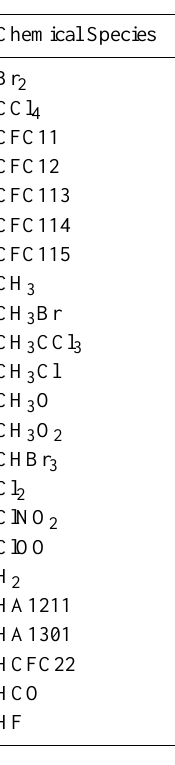
Table 1. Initial conditions for chemical species where mixing ratio is specified constant with altitude. Units are in mixing ratio. Initial mixing ratios that depend on altitude are given in Fig. 1.